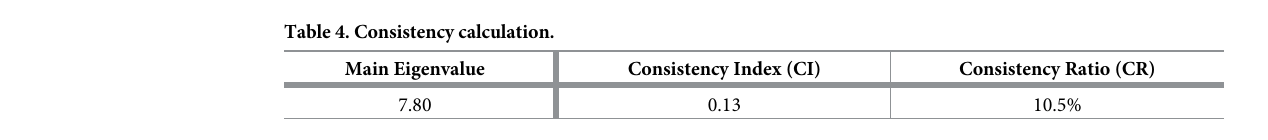
This table presents the results obtained with the consistency calculation of the AHP model.